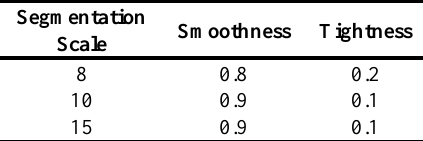
Table 5.Set split parameters